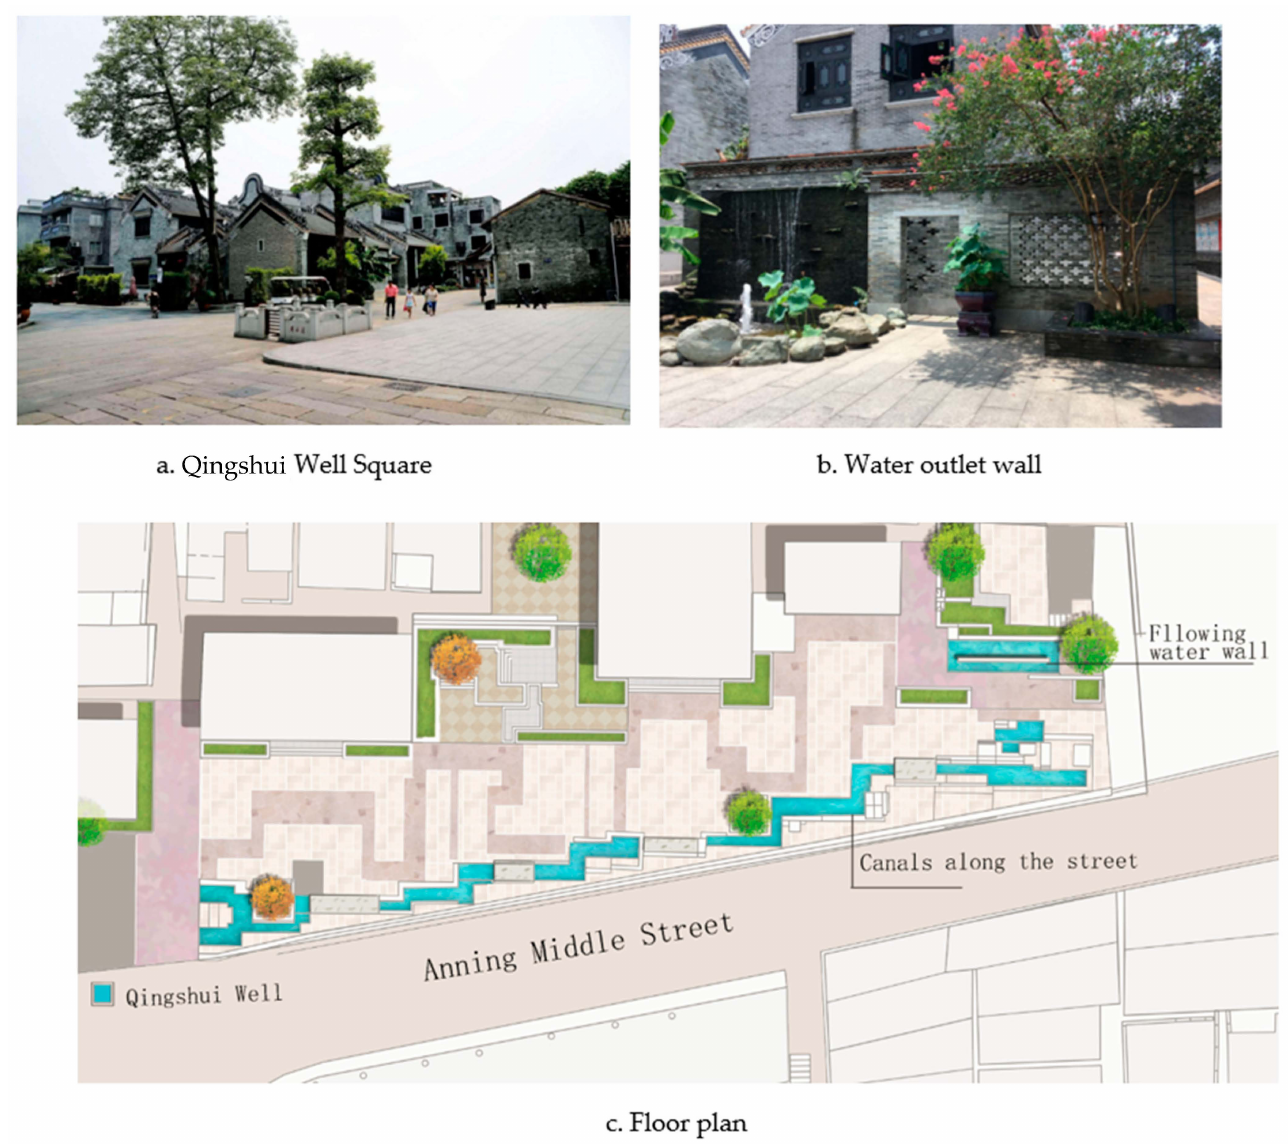
Figure 15. Qingshui Well Square. (Source: the authors.).